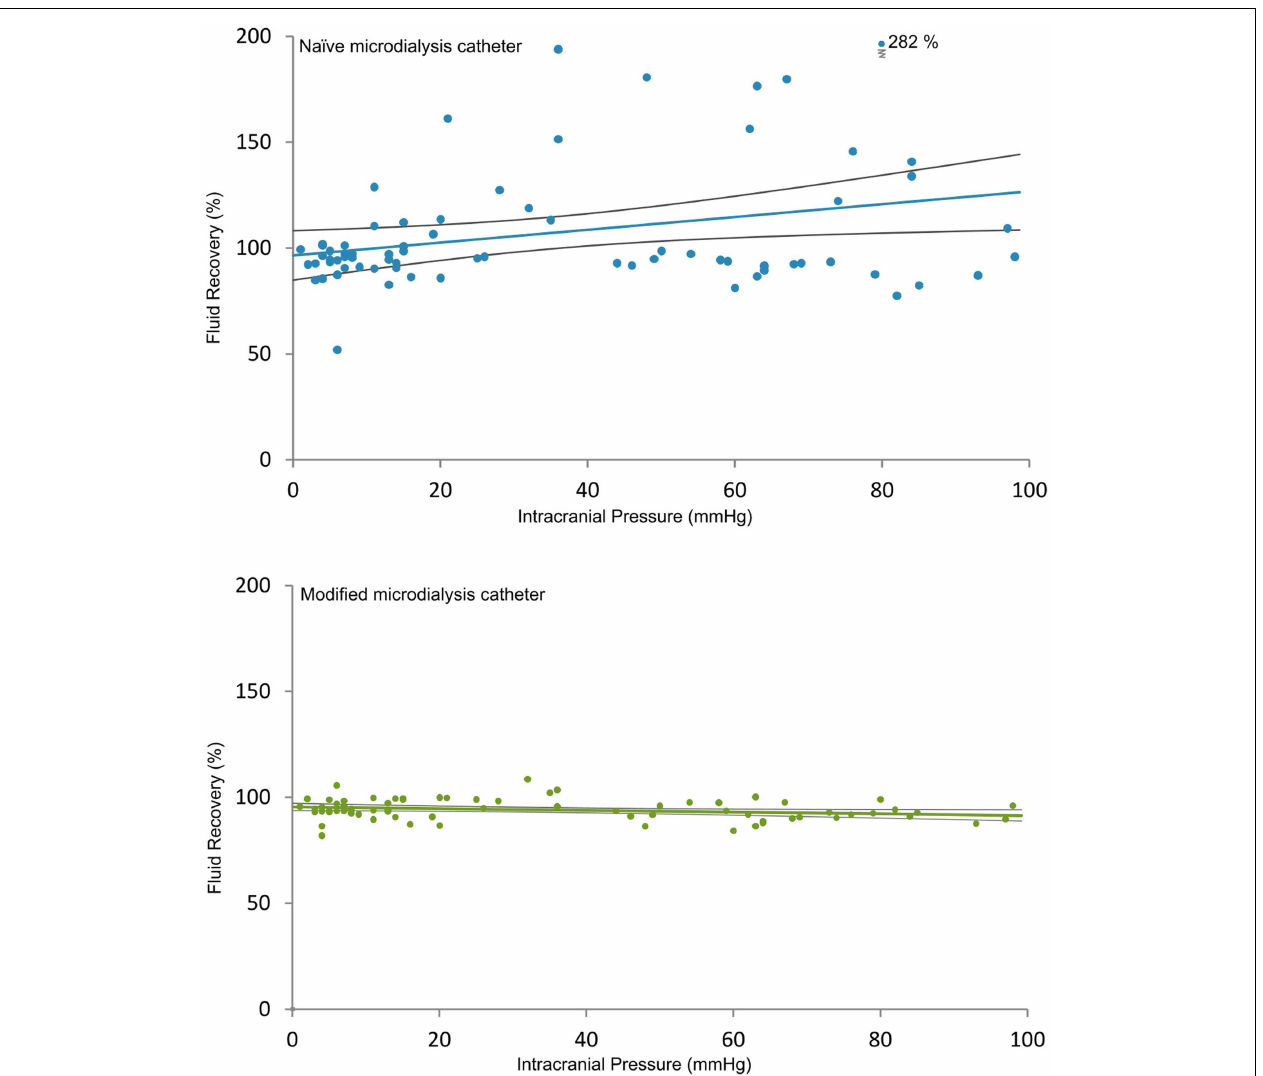
shows a significant positive correlation between FR and ICP in naïve MD catheters with a high degree of variability ( r = 0.30, p = 0.02, Standard Error of Estimate = 32.3). Lower panel shows that this correlation switched to a weak negative relation in modified catheters with markedly reduced scatter ( r =− 0.04, p = 0.04, Standard Error of Estimate = 4.8), suggesting a more stable MD performance as a result of surface modification (16). Reprinted with permission from Dahlin et al. (16). Copyright American Chemical